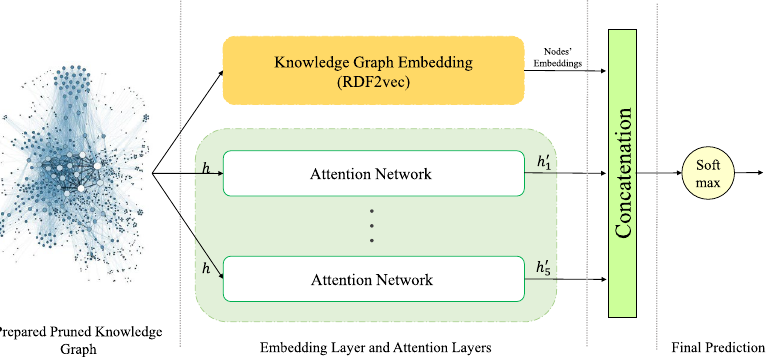
Figure 4. The architecture of knowledge graph attention network classifier which is enriched by knowledge graph embedding. The predictions perform individually in each of the five {O, C, E, A, and N} personality